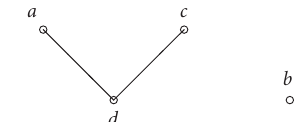
Figure 1: Figure of S for Example